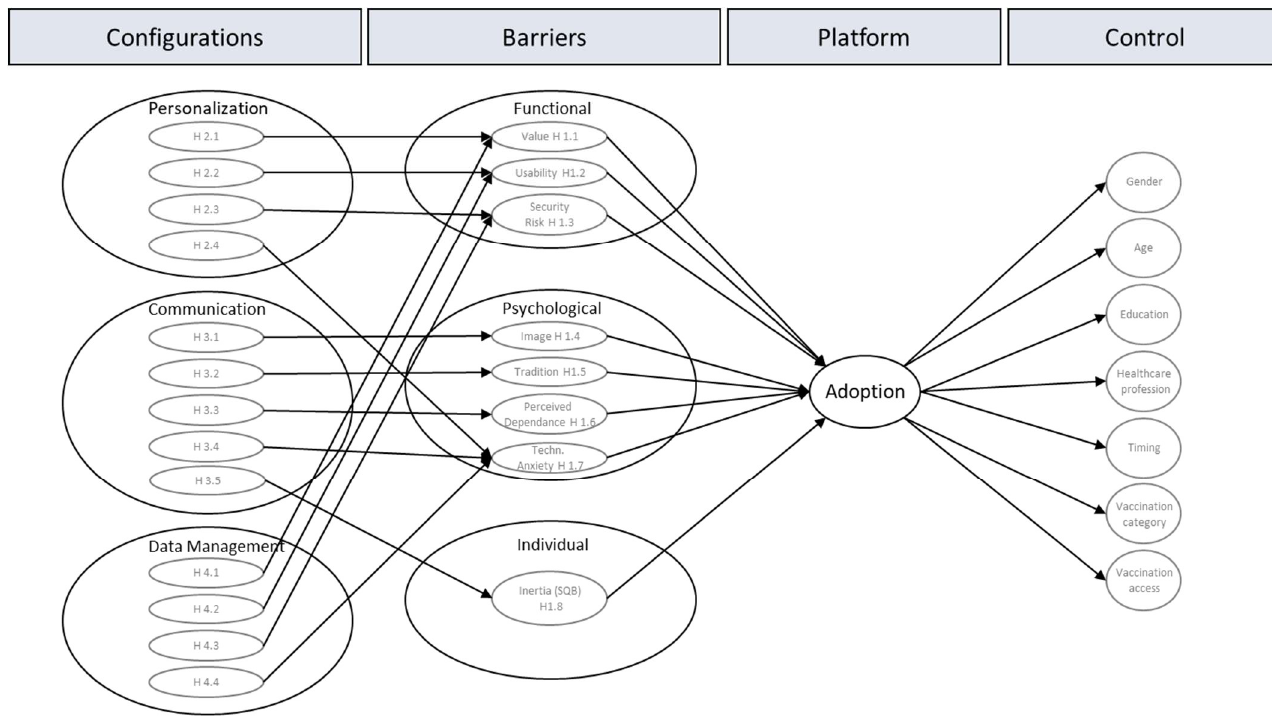
Figure 1. Adoption Model for digital platform services to manage COVID-19 vaccination (based on Mani and Chouk [27]).